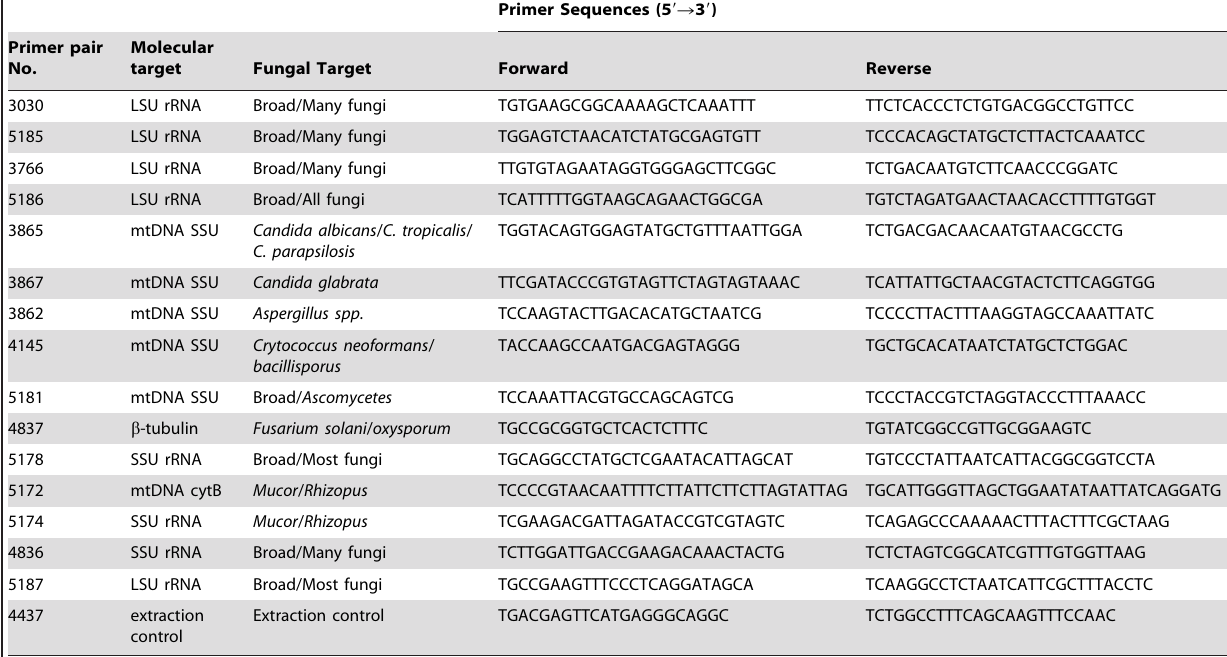
Primer Sequences (5 9 R 3 9 )